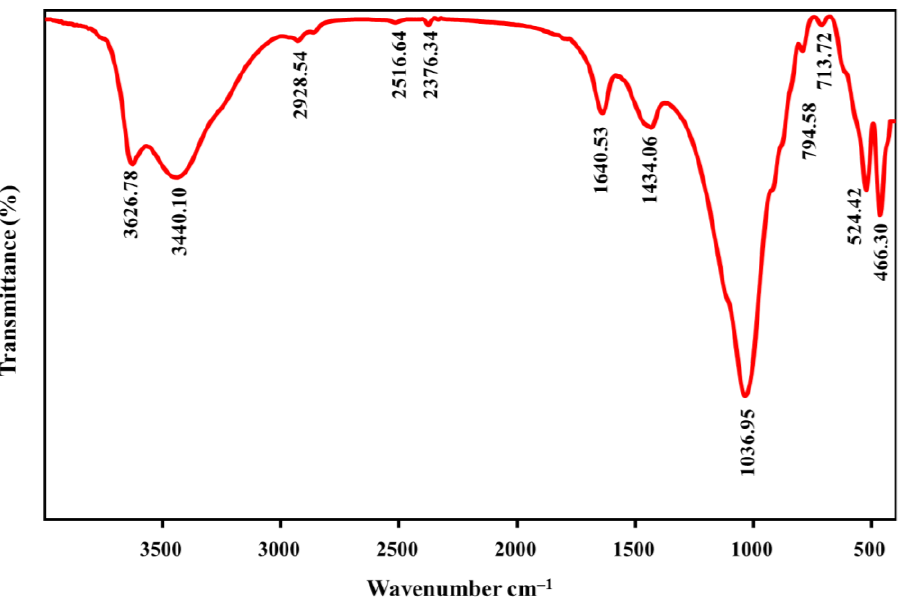
Figure 3. FTIR spectrum of the developed BE/SD – MNPs